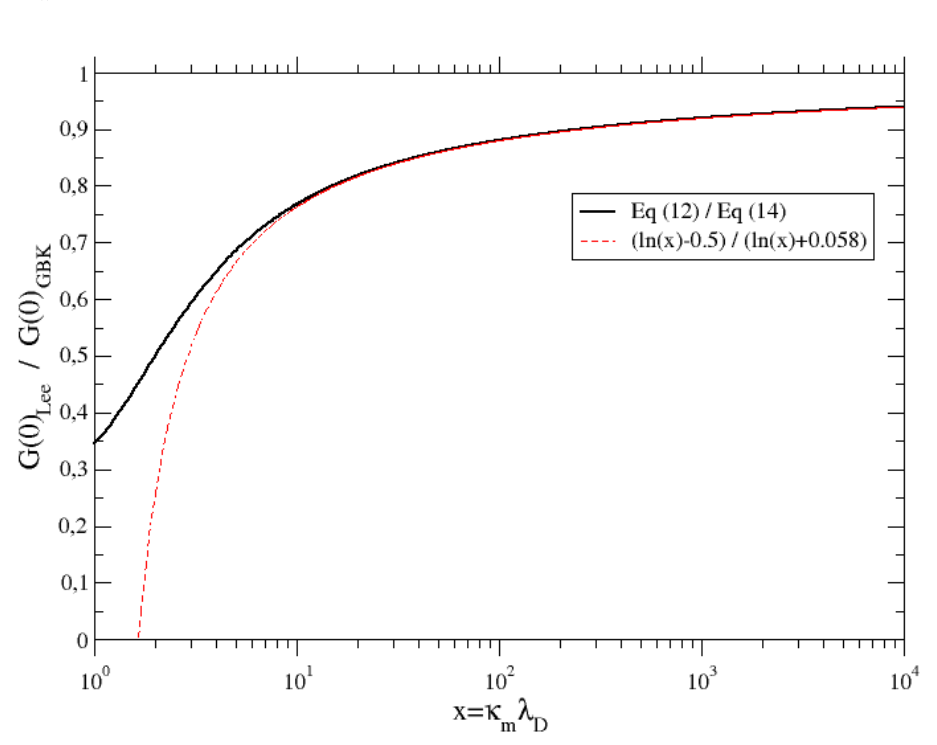
Figure 2. Discrepancies on the electron impact widths at the line center (Lee versus GBK), as a function the parameter κ m λ D which represents the ratio of maximal over minimal impact parameters for the electron-radiator